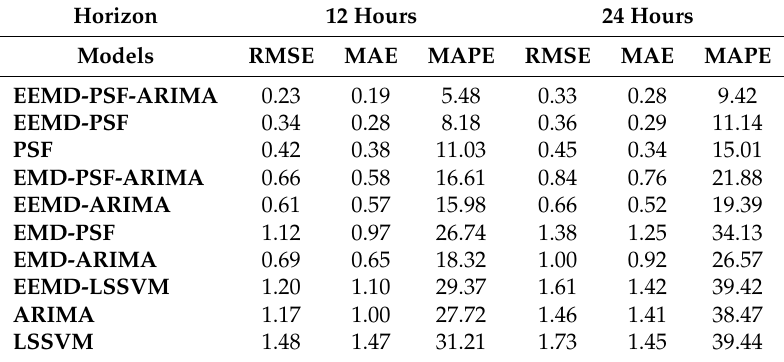
Table 10. Comparison of the proposed methods with the reported methods on RMSE, MAE and MAPE for horizon prediction (direct strategy) of 12 and 24 h with wind speed